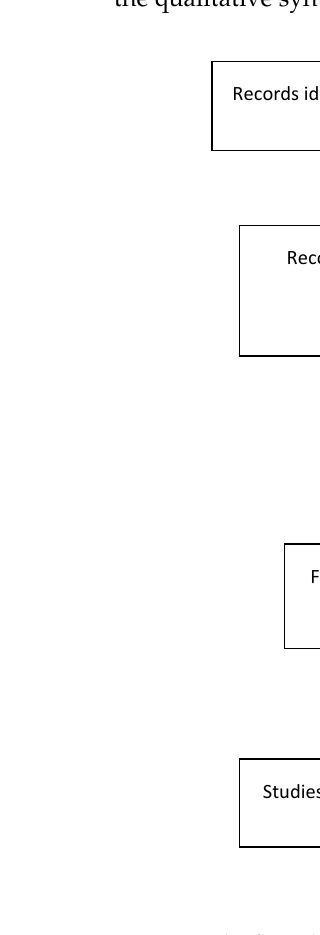
Figure 1. The flow diagram of the process of study selection.